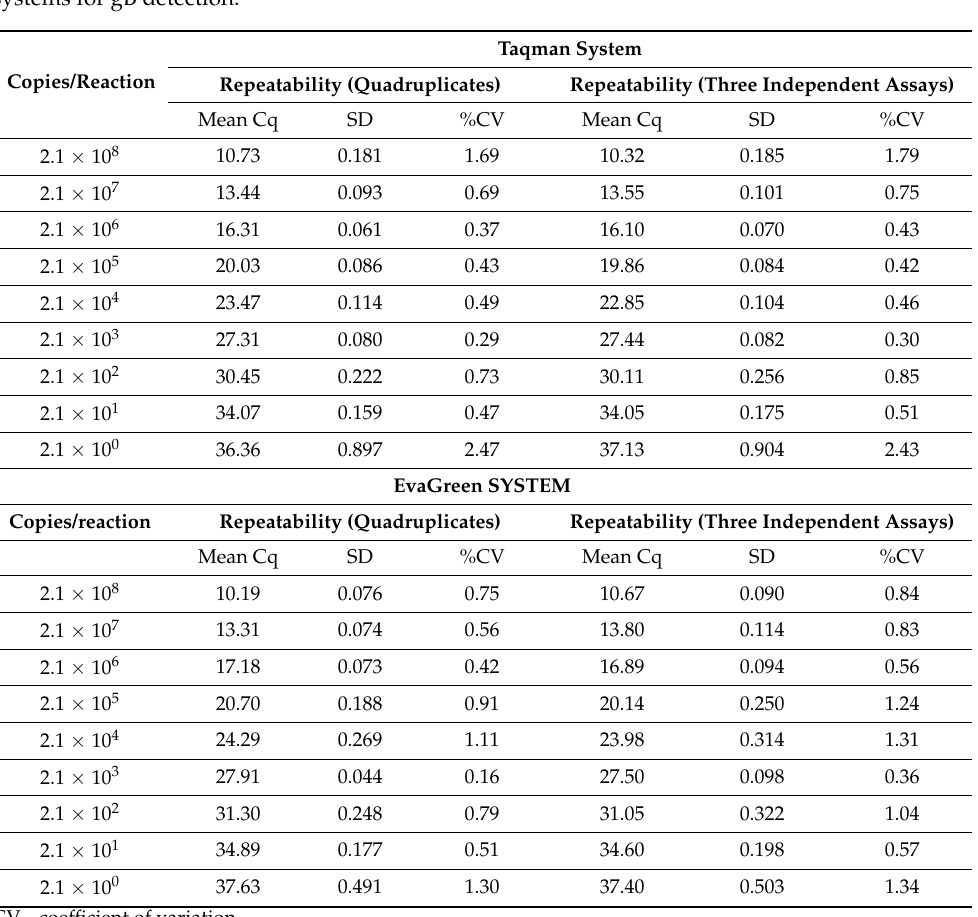
Table 3. Summary of statistical analyses of the repeatability and reproducibility results for both qPCR systems for gB